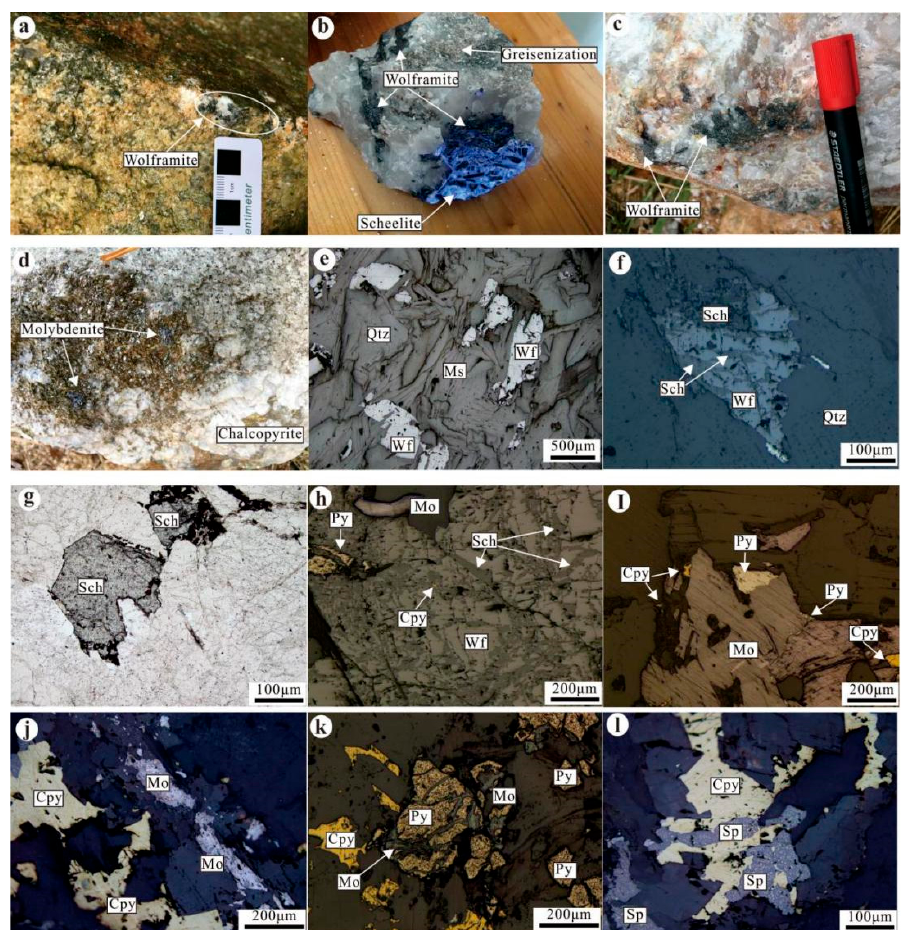
Figure 6. ( a – c , f – h ) Ore and photomicrograph of quarz-wolframite vein from Chuankou ore field, ( d , e ) Ore and photomicrograph of alterated granite type wolframite. ( a – h ), Medium to high temperature hydrothermal mineralization stage, ( i – l ), Medium to low temperature hydrothermal mineralization stage. Sch- scheelite; Wf- wolframite; Ms- muscovite; Py- pyrite, Cpy- chalcopyrite, Sp- sphalerite, Mo- molybdenite, Qtz- quartz.